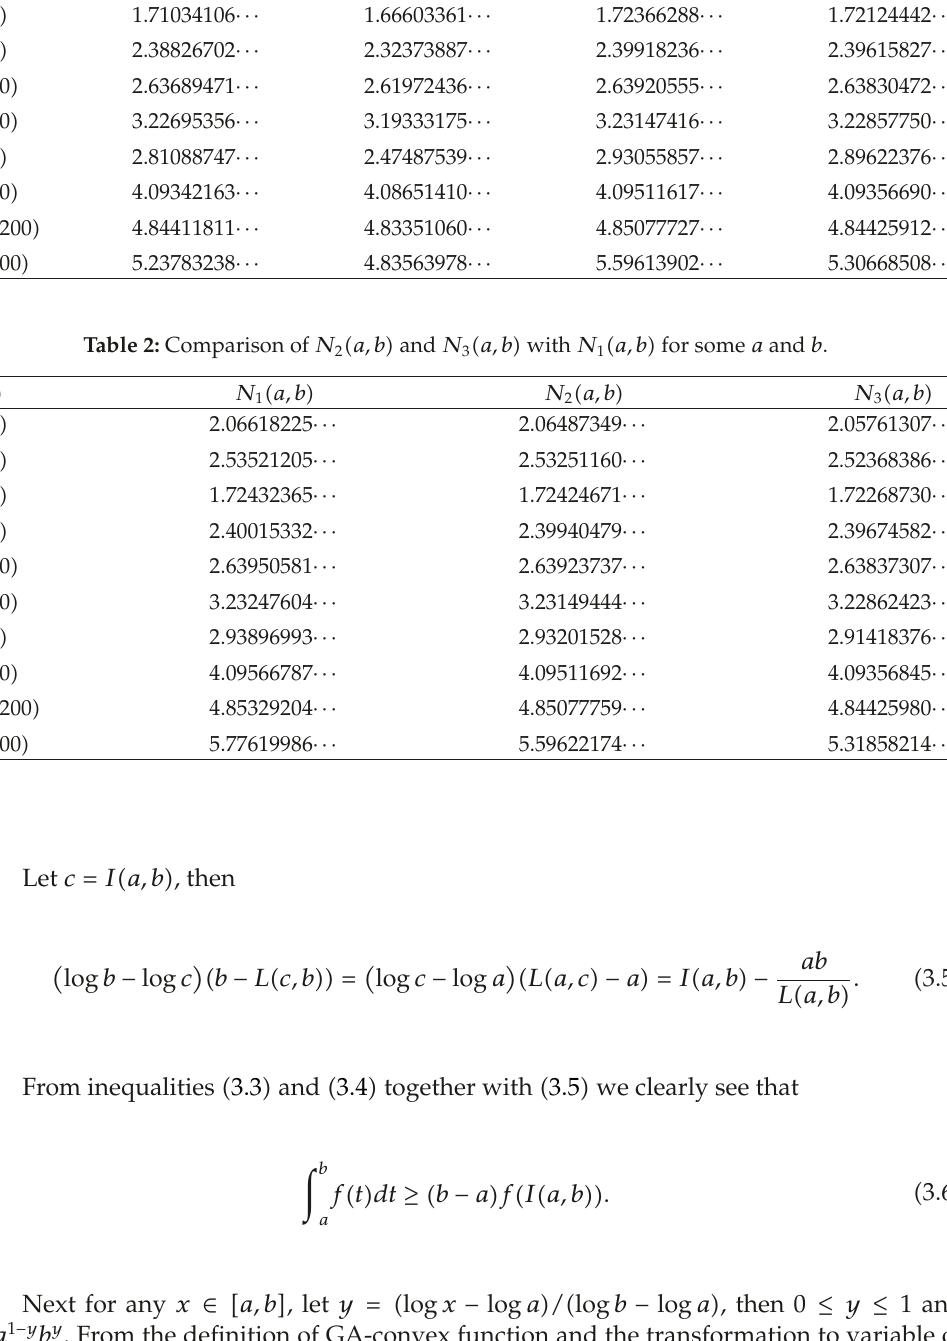
(cid:2) a,b (cid:3) with M 4